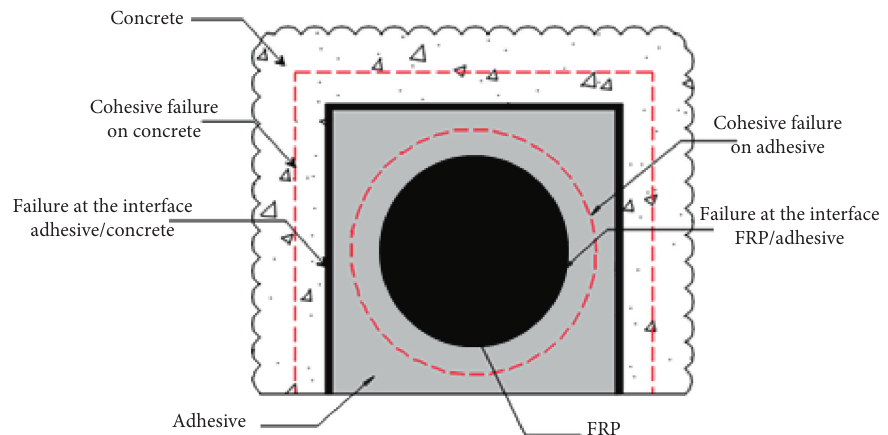
Figure 2: Possible failure modes associated with debonding mechanism